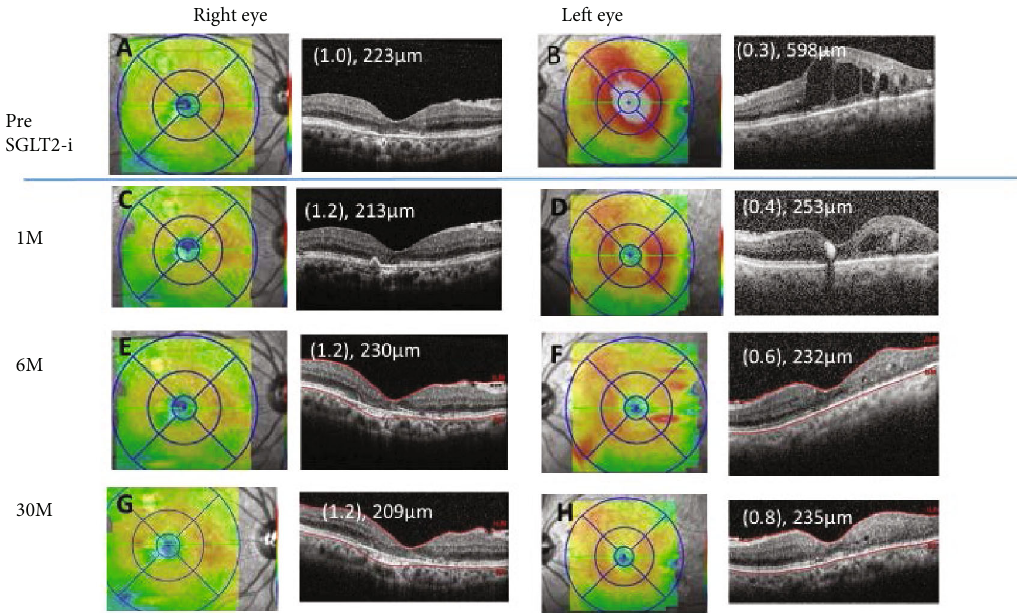
Figure 1: Case 1. Optical coherence tomographic images and fundus photographs showing the central retinal thickness (CRT) pre (A, B), at 1 month (M) (C, D), 6 M (E, F), and 30M (G, H) after commencing the oral sodium-glucose cotransporter 2 inhibitor